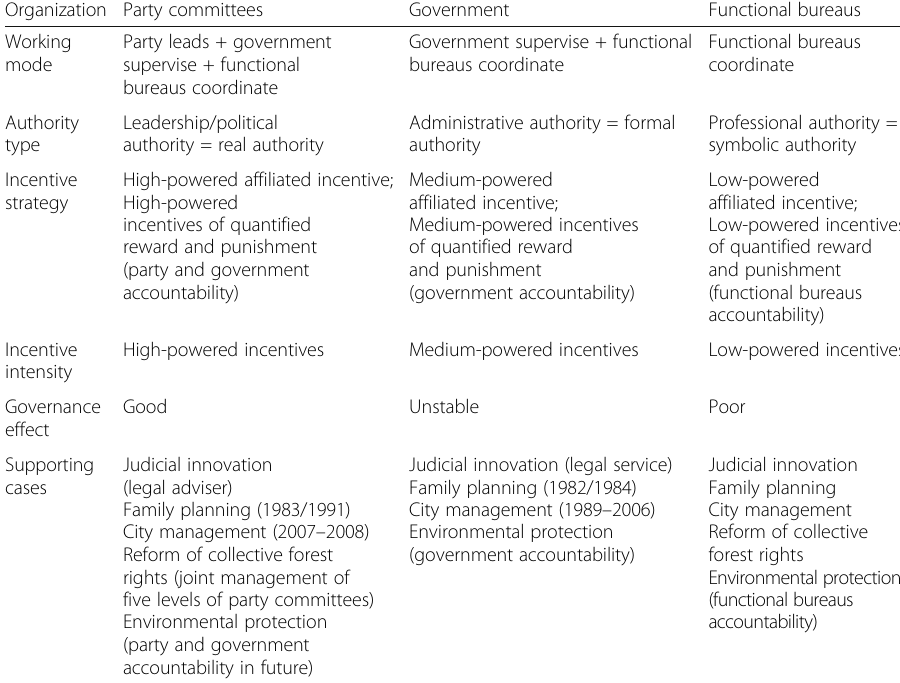
Table 2 A multi-case study Organization Party